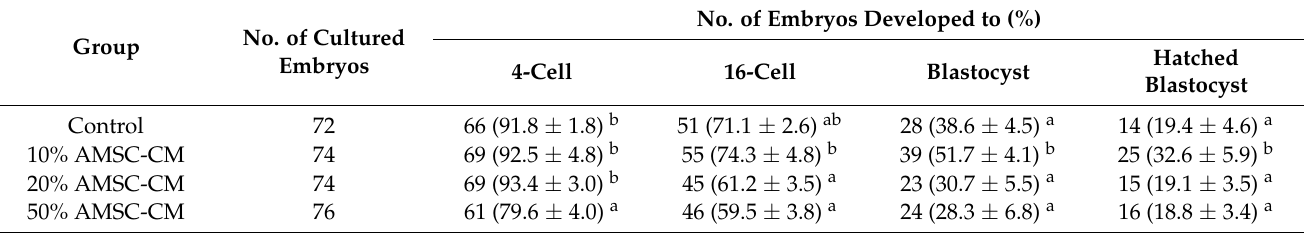
Table 2. Effect of human amniotic membrane-derived mesenchymal stem cell conditioned medium (AMSC-CM) on in vitro fertilized mouse embryos development.